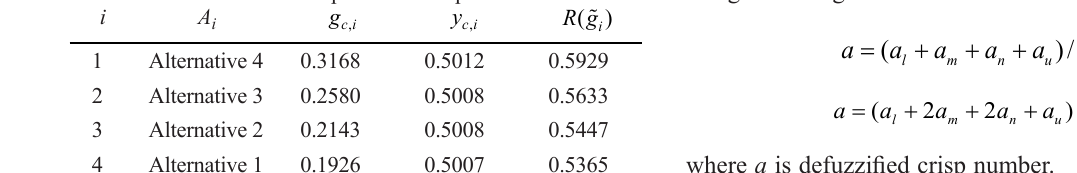
Table 8. Global priorities according to proposed procedure and other procedures Rank Alternative i A i